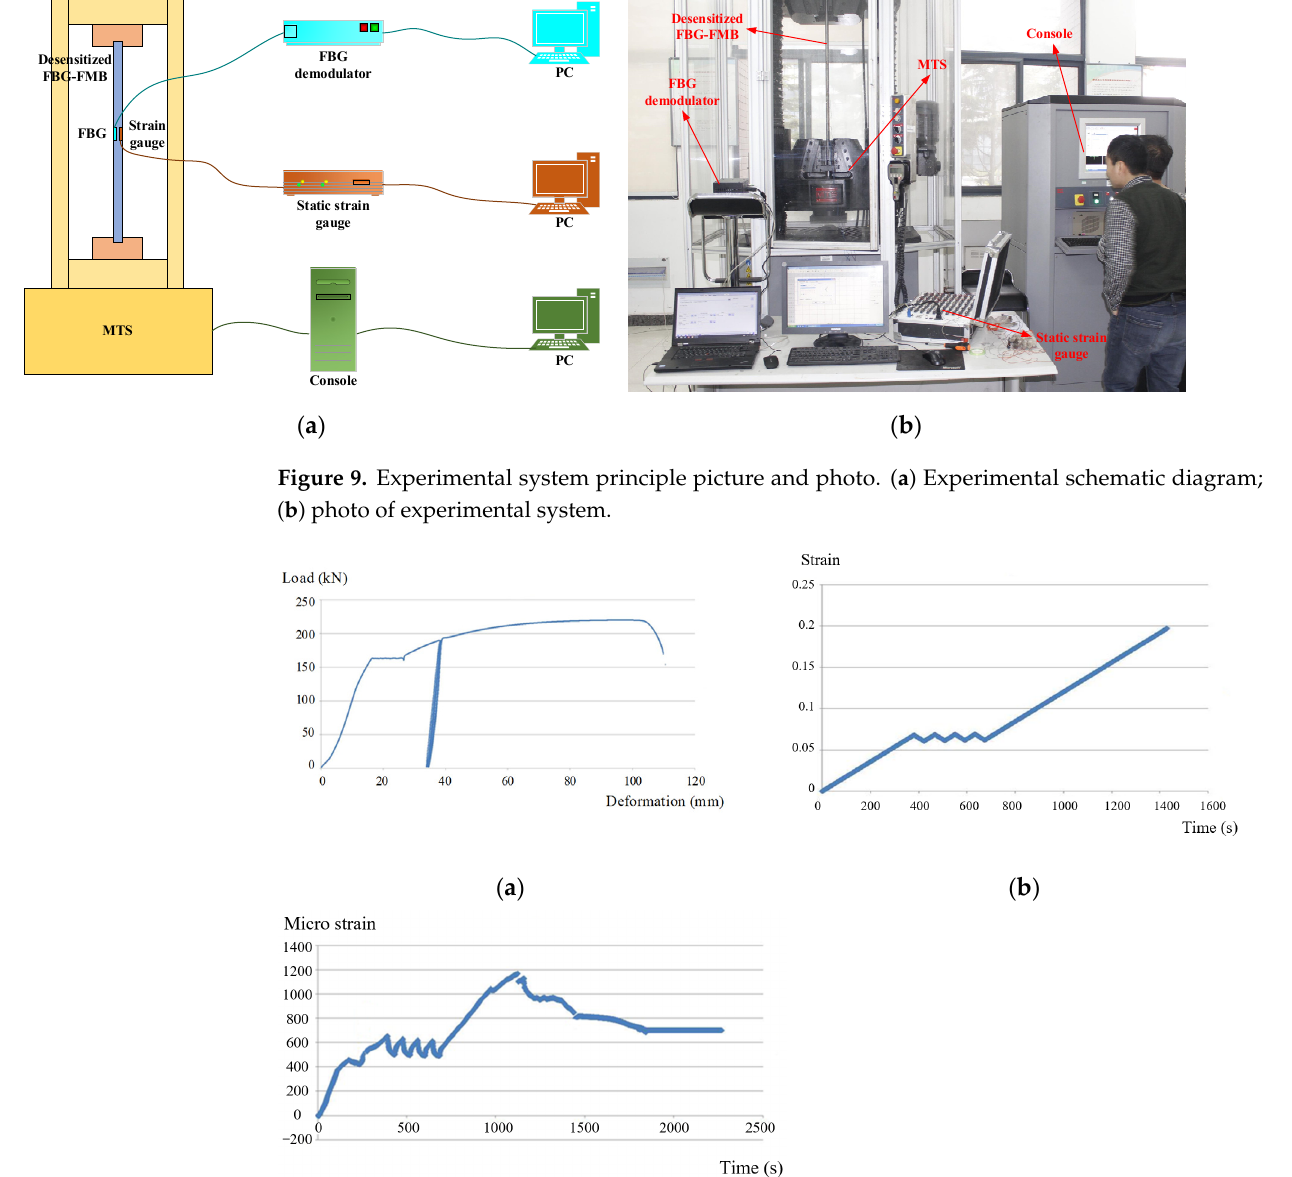
Figure 9. Experimental system principle picture and photo. ( a ) Experimental schematic diagram; ( b ) photo of experimental system.